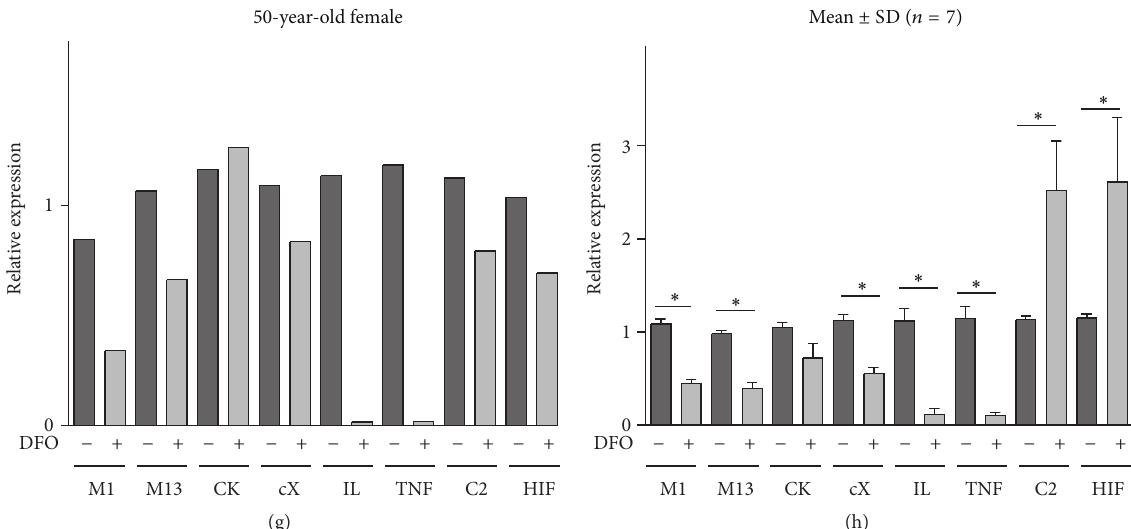
Figure 3: Effects of DFO on the expression of genes responsible for collagen cleavage, chondrocyte hypertrophy and inflammation, collagen synthesis, and hypoxia. Relative gene expression with reference to 𝛽 -actin is compared with controls, as determined by real-time PCR analyses in osteoarthriticcartilage explant culturesin thepresence or absence (control)of 10 𝜇 Mdeferoxamine (DFO) at 48 hours. Themeans ± SDs for all seven patients (a–g) are shown in (h) (Wilcoxon matched pairs test). Asterisks ( ∗ ) indicate significant differences compared to the control ( 𝑝 < 0.05 ). The age and gender of each patient are indicated. M1, MMP-1; M13, MMP-13; CK, cathepsin K; cX, COL10A1; C2, COL2A1; HIF, HIF1 𝛼 ; IL, IL-1 𝛽 ; TNF, TNF 𝛼